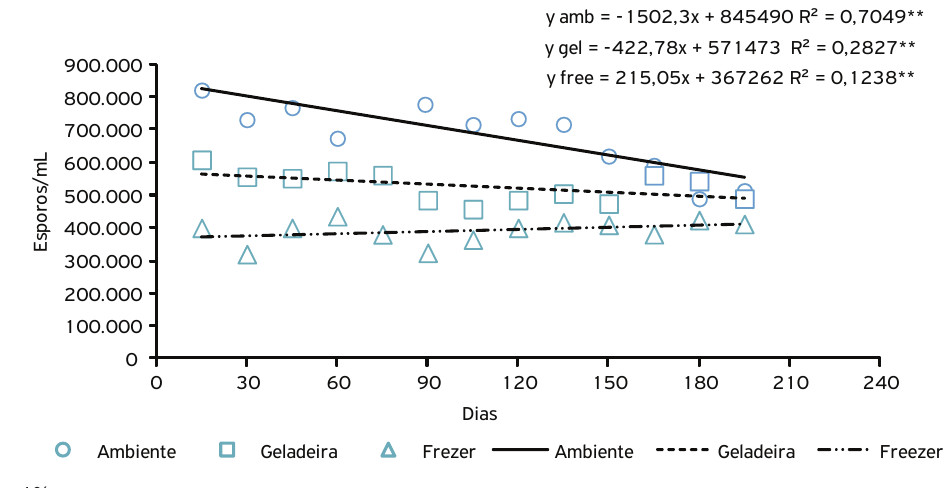
Figura 4. Esporulação do fungo A. niger imobilizado em alginato de sódio e submetido a diferentes temperaturas de armazenamento.